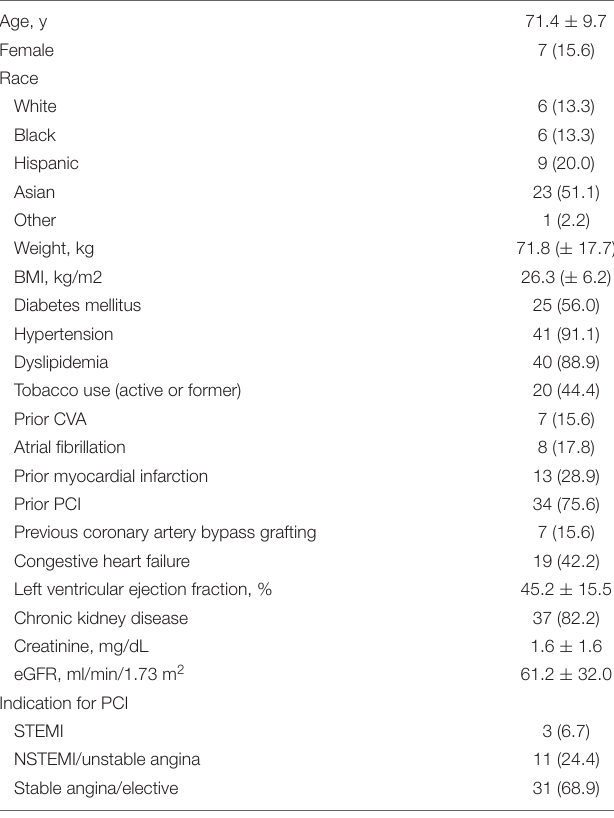
TABLE 1 | Baseline clinical characteristics ( n =